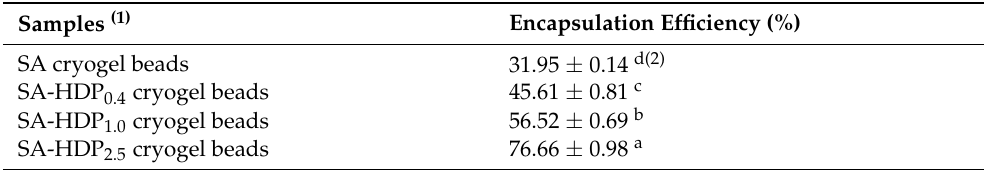
Table 1. Encapsulation efficiency of curcumin in sodium alginate (SA)-based cryogel beads filled with different concentrations of hydroxypropyl distarch phosphate